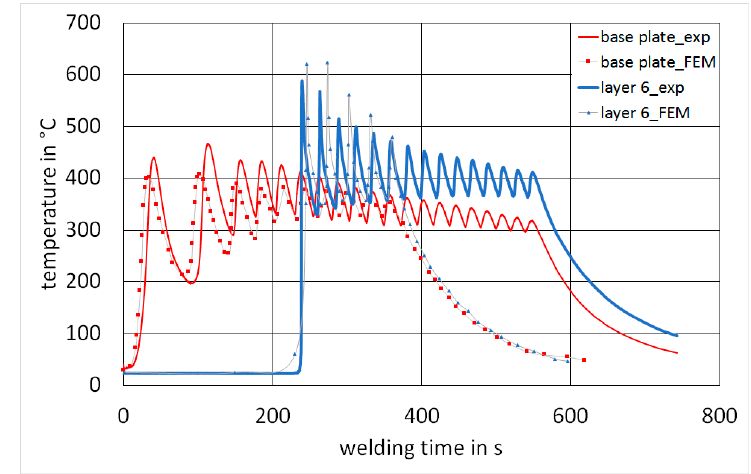
Figure 10. Comparison of measured (solid line) and simulated (dotted line) temperature for AZ31 in the base plate and layer 6 with v wire = 5.0 m/min and v welding = 40 cm/min.